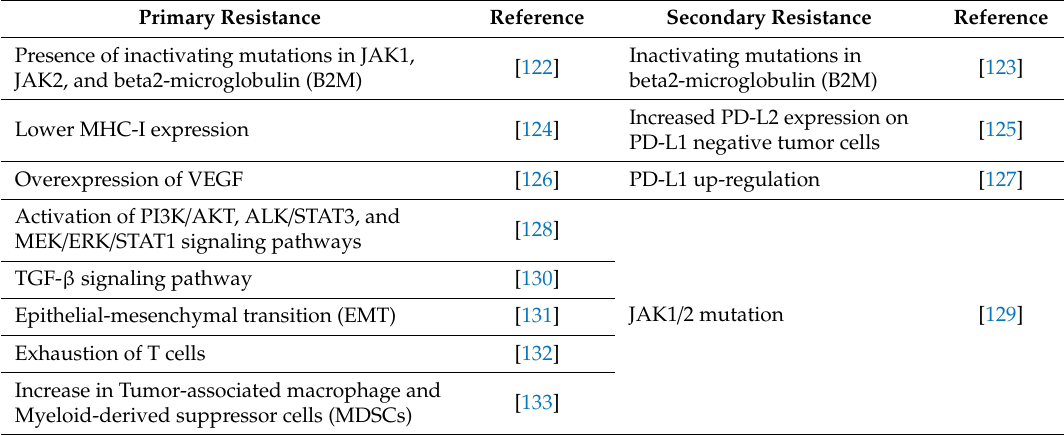
Table 9. Mechanism of primary and secondary resistance to checkpoint